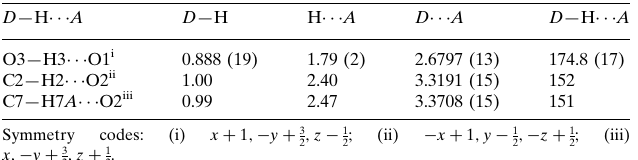
Hydrogen-bond geometry (A˚ , (cid:2)